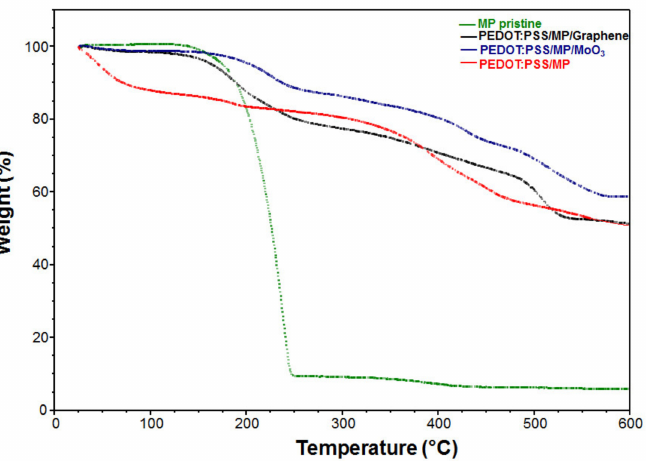
Figure 11. TGA thermogram of MP pristine, PEDOT:PSS/MP/graphene, PEDOT:PSS/MP/MoO 3 , and PEDOT:PSS/MP